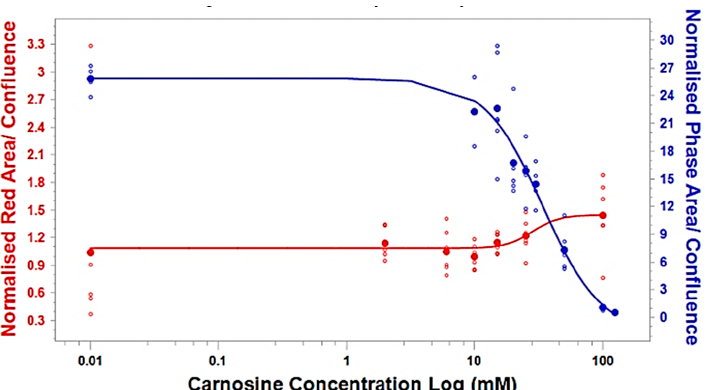
Figure 8. IncuCyte S3 live cell system (10×) live cell images analysis shows IC50/EC50 curves of the inhibition of cells’ proliferation and the efficiency of carnosine in killing the tumour cells. Upon carnosine exposure at different concentrations (0, 50, 100, 125 mM) over 48 h, IC50 is indicated by the confluence phase ratio, while EC50 is the ratio of the Cytotox Red dye that enters dead cells. The carnosine effect has three phases: o effect, Cytostatic, and Cytotoxic.